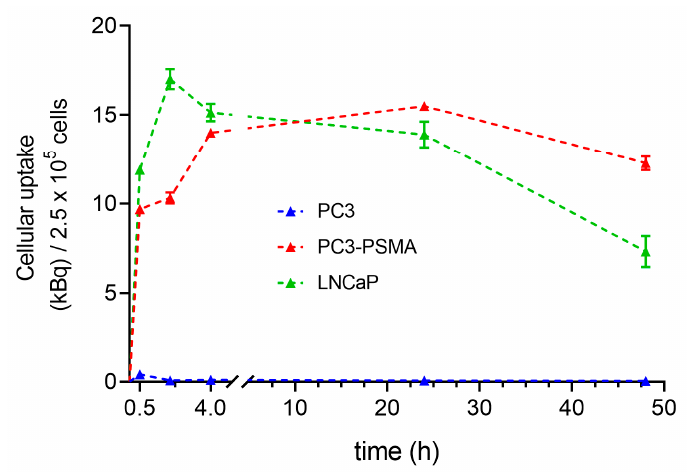
Figure 3. Kinetic data of uptake measurements in PC3, PC3-PSMA, and LNCaP cells at predetermined time points (0.5, 2, 4, 24, and 48 h) after incubation with Lu-177–PSMA-617. Results are displayed as internalized radioactivity (mean ± SD) normalized to 2.5 × 10 5 cells.